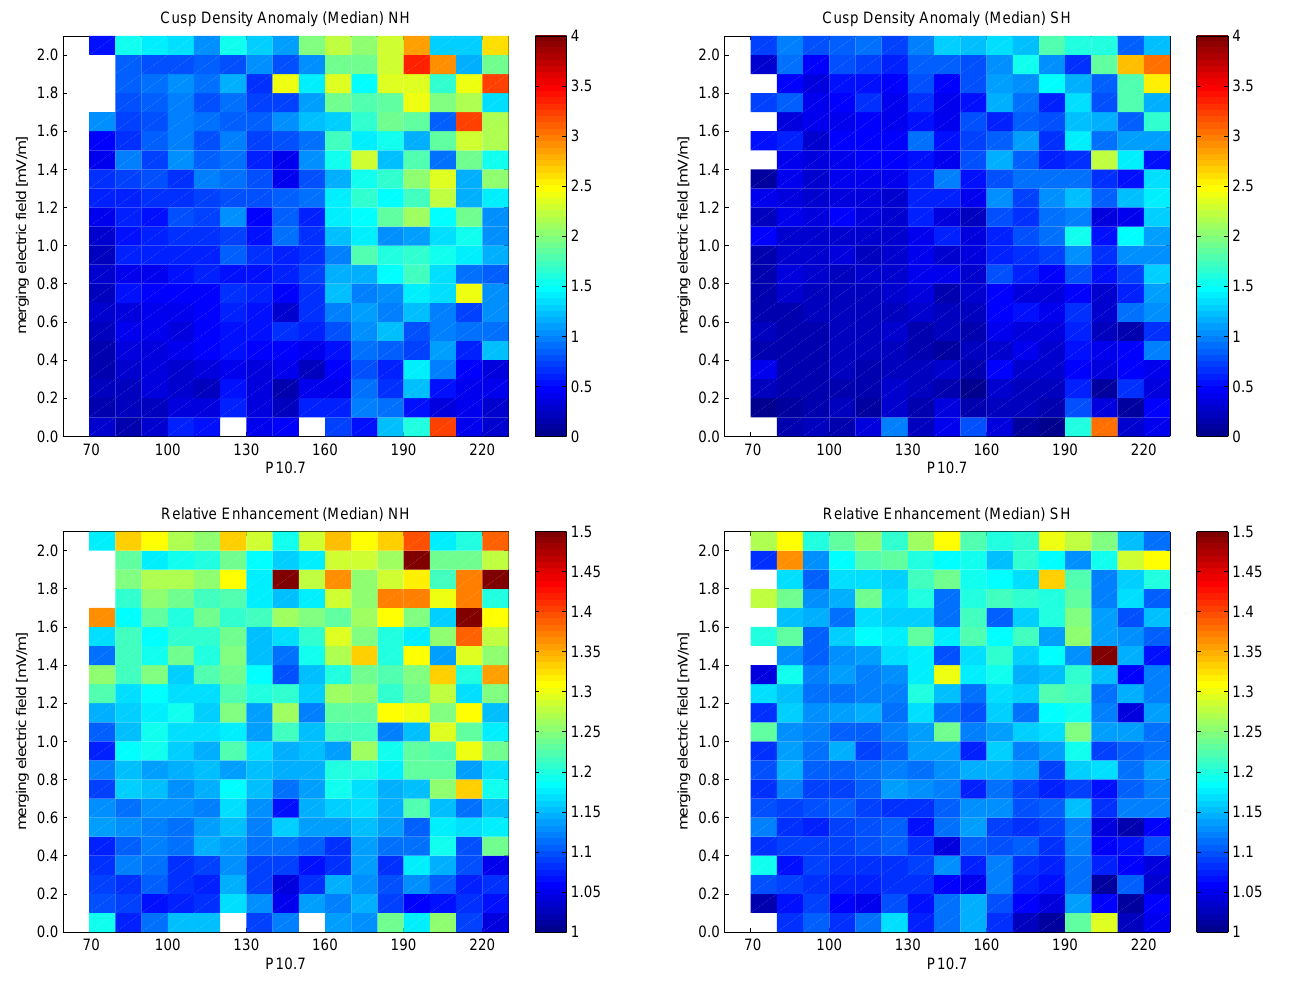
Fig. 7. A 2-D distribution of the density anomaly (in 10 − 12 kg / m 3 , colour scale) depending on E merg and P10.7 for both hemispheres (upper row). Largest density values are concentrated in the sector of high solar activity and elevated E merg values. The same is displayed for the relative anomaly (lower row). Large relative enhancements occur at elevated E merg conditions over a wider range of P10.7 levels.